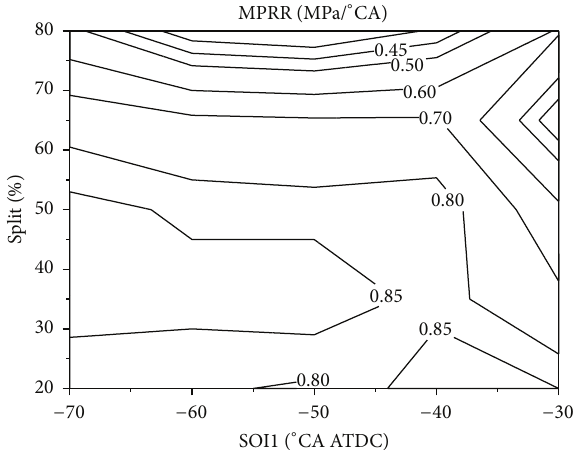
Figure 5: MPRR as a function of SOI1 and split percentage.